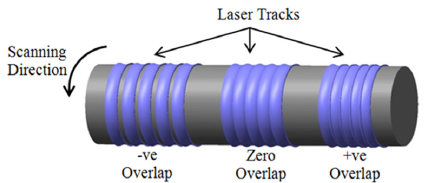
Figure 3. The three overlapping scenarios used for surface laser scanning passes, determined by setting the rate of longitudinal translation of the laser beam.